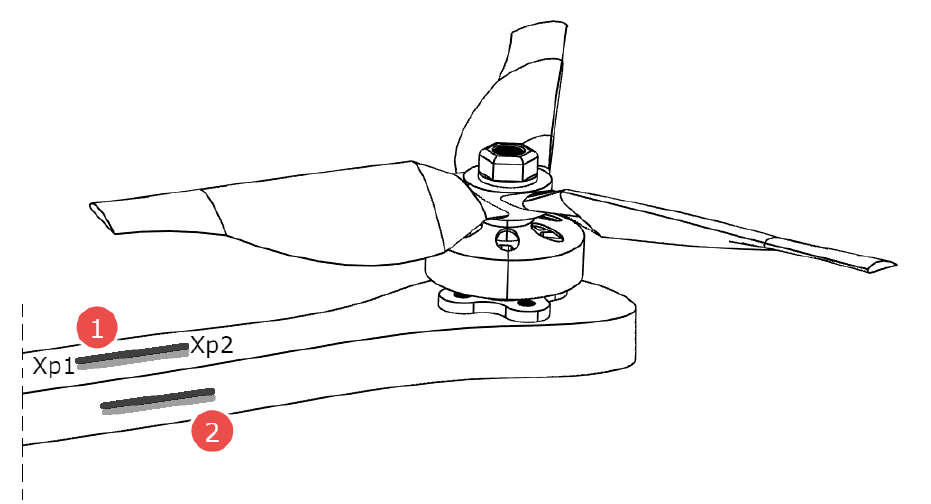
Figure 9. Mounting places of the piezo sensor (1—upper location, 2—side